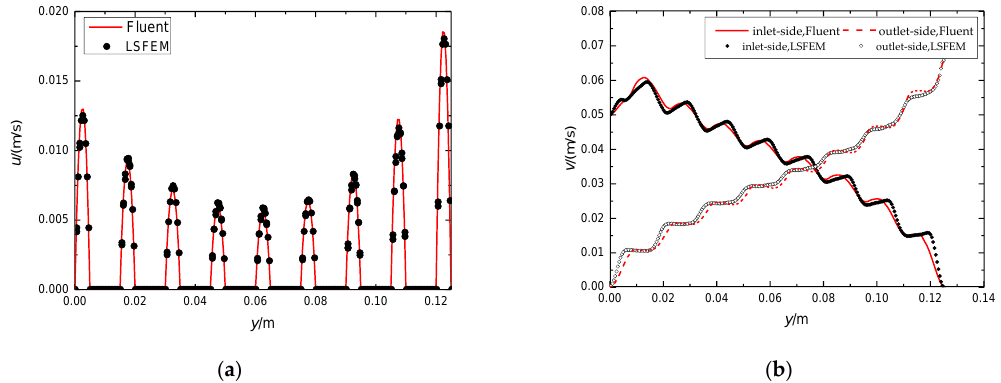
Figure 4. ( a ) Velocity distribution of u along the vertical center line; ( b ) Velocity distribution of v along the vertical center line of the vertical oil ducts.